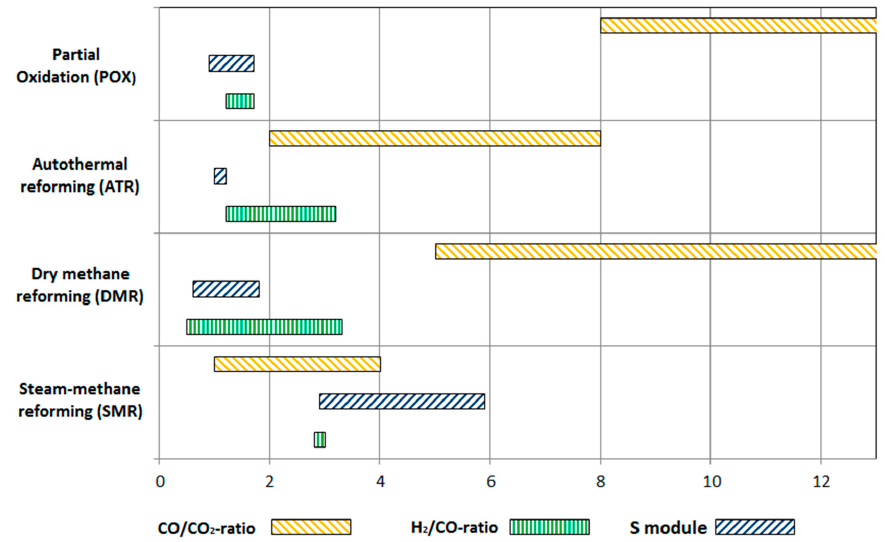
Figure 1. Range of the syngas composition for the commercially applied methane reforming technologies. The composition is expressed by the three main stoichiometric